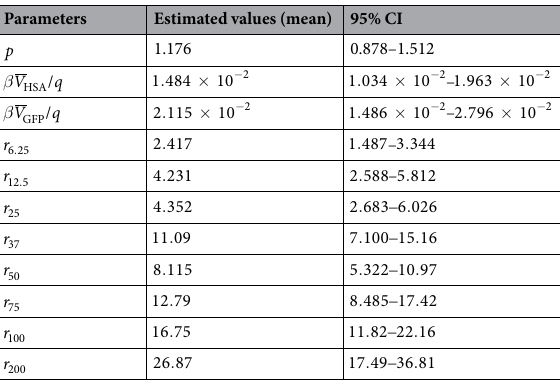
Table 1. Estimated parameters in the mathematical model of cell-free